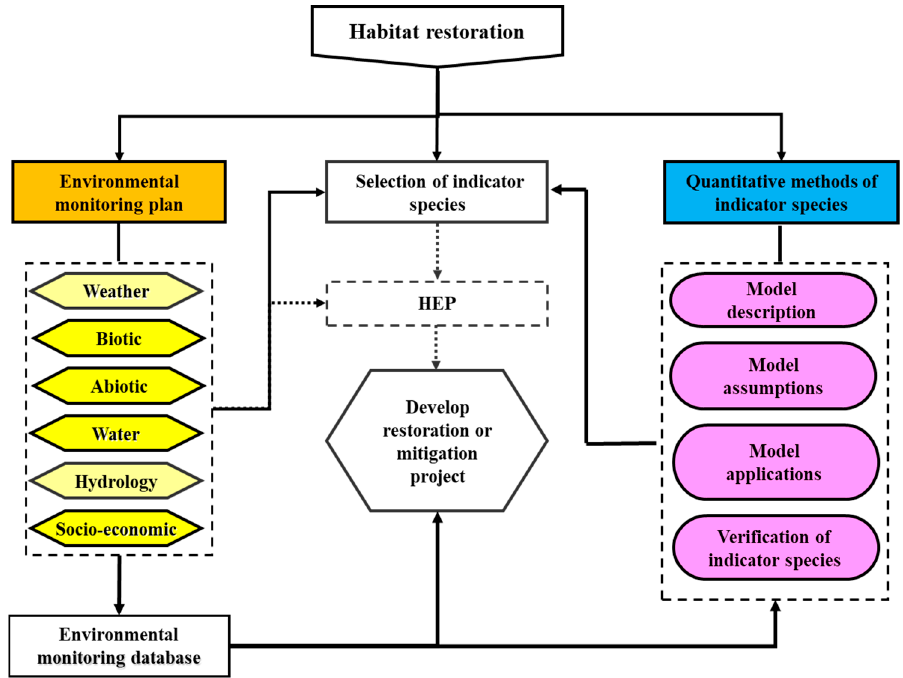
Figure 4. A mechanism and procedure for formulating a rehabilitation of mitigation project by using indicator species. indicator